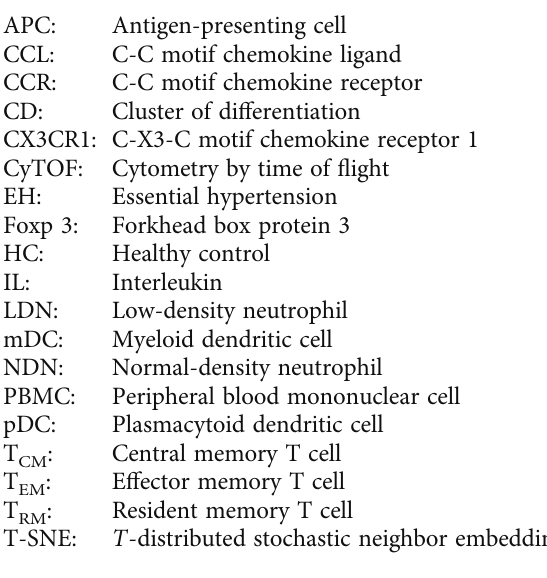
Supplementary materials and methods. Table S1: CyTOF staining panel of antibodies. Figure S1: the di ff erence in the average expression level of 42 kinds of markers in CD45 + cells between the HC and EH groups. Table S2: markers in EH. Figure S2: pseudotime analysis of monocytes (merge sample). (a) The pseudotime analysis of CD14. (b) The pseu- dotime analysis of CD16. Table S3: the correlation between indexes and blood pressure/age. (Supplementary